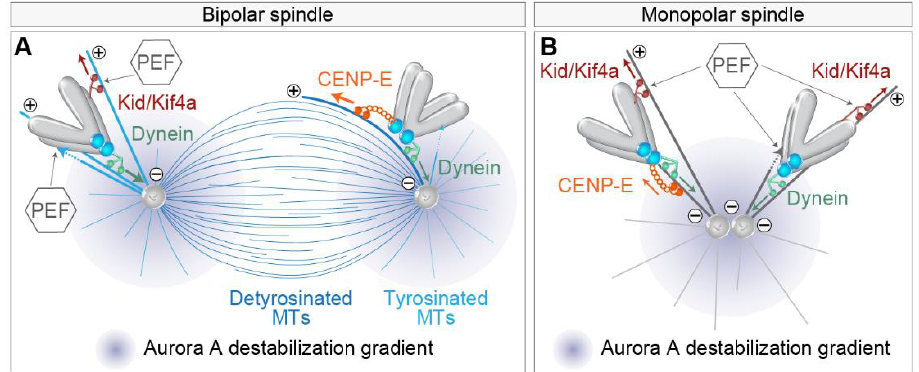
Figure 4. Mechanisms that set the distance between the chromosome and the spindle pole in bipolar and monopolar spindles. ( A ) Chromosome proximity to the pole where the Aurora A gradient is centered (purple gradient) controls its end-on attachment status to microtubules by the balance of poleward dynein (green arrows), anti-poleward polar ejection (PEF), and CENP-E (orange arrows) forces in the bipolar spindle. The extent of CENP-E motor activity behind and in the front of the spindle pole is controlled by the tubulin tyrosination state (microtubules in two different shades of blue). PEF activity is represented by the plus end directed walking of Kid and Kif4a motors on microtubules (red arrows) or direct microtubule pushing into the chromosome arm by polymerization (dotted lines from a microtubule tip). The thickness of the colored arrows indicates the strength of each force. MTs, microtubules. ( B ) Mechanisms that regulate the proximity of chromosomes to poles in the monopolar spindle. Legend as in ( A